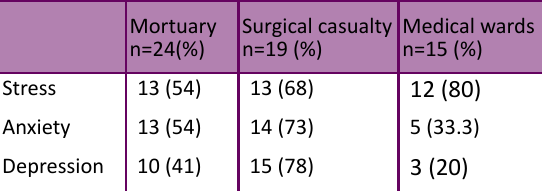
Table 1. Health professionals with positive DASS scores for stress, anxiety and depression